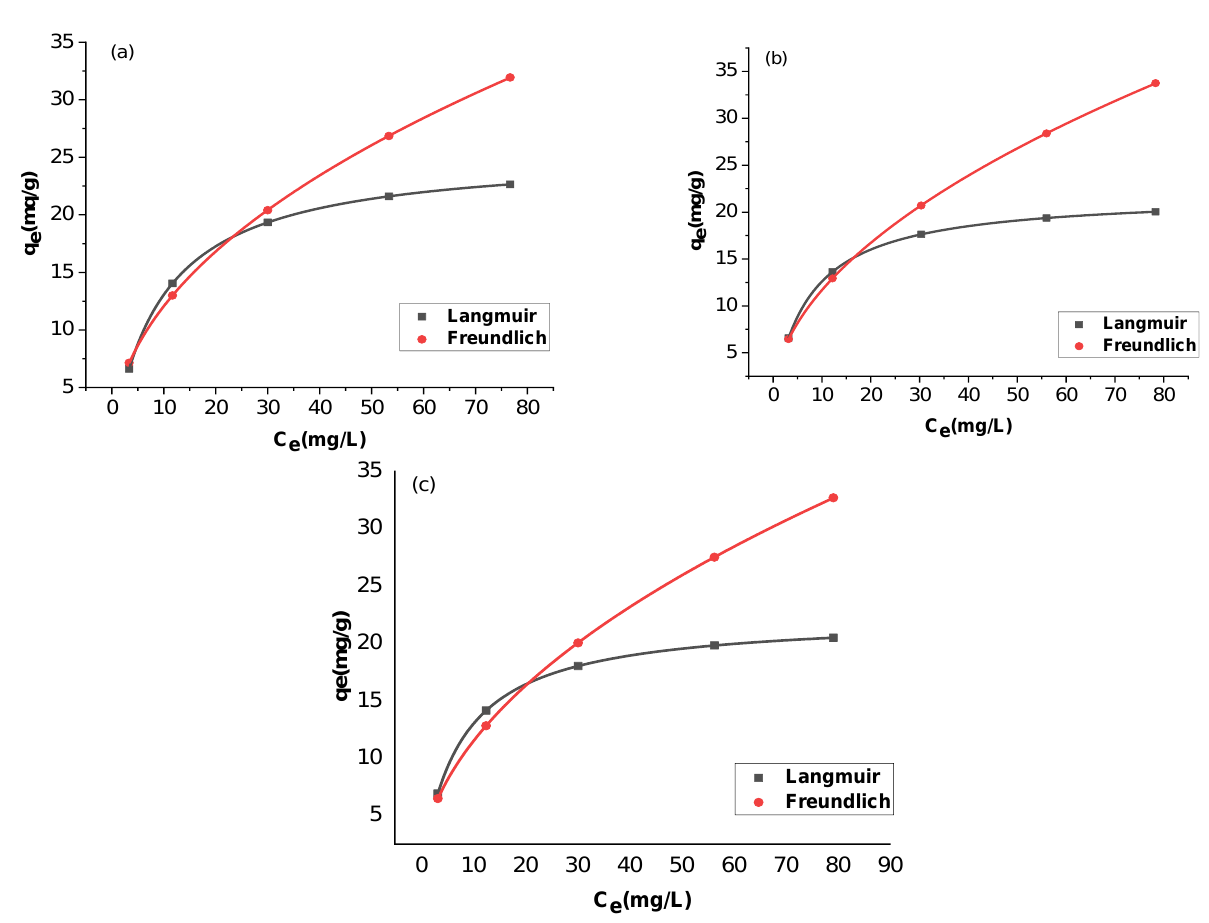
Figure 13. Nonlinear fitting of rGO-ZnO at 298 K ( a ), 303 K ( b ), and 308 K ( c ). Table 2. Sorption capacities of various reported adsorbents for Cr (VI). Adsorbent q m